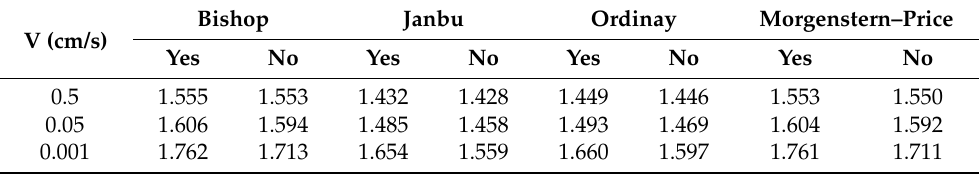
Table 3. Comparison of the influence of matrix suction on the safety factor of the slope. Bishop Janbu Ordinay Morgenstern–Price V (cm/s) Yes No Yes Yes Yes No